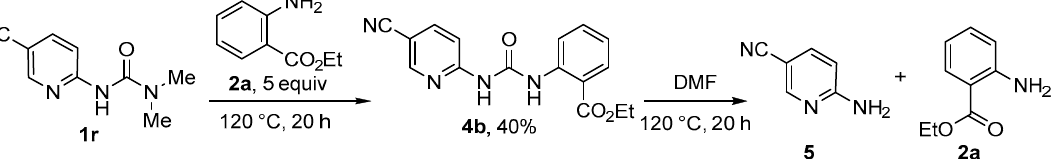
Scheme 4. Formation and destruction of ethyl 2-(3-(5-cyanopyridin-2-yl)ureido)benzoate 4b under the reaction conditions.